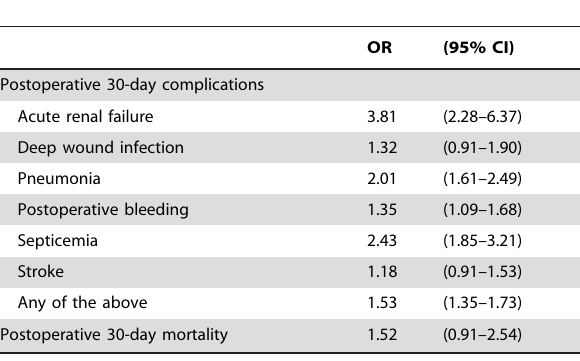
Table 2. Risk of postoperative 30-day mortality and complications associated with intellectual disability in multiple logistic regression models *